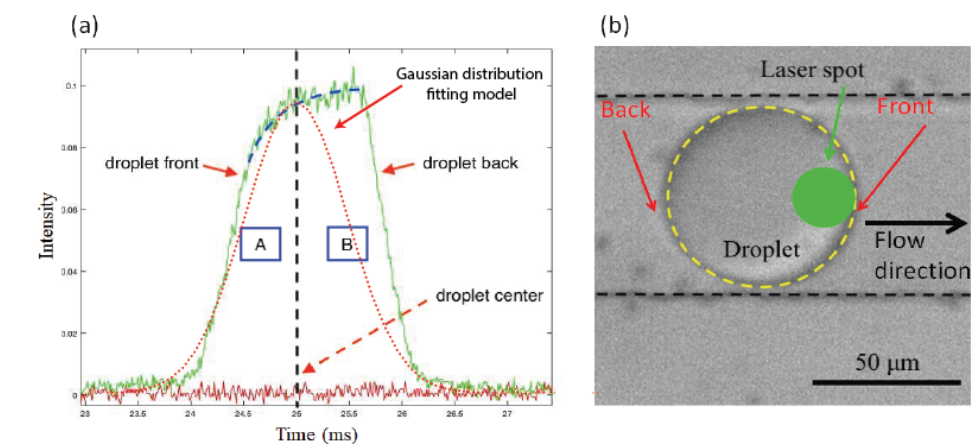
Figure 12. Shape of the fluorescence intensity signal versus time emitted from RhB-doped ZnO microdroplets in the presence of dSURF surfactant ( a ). The corresponding optical microscopic image of the microdroplet flowing inside the microfluidic channel ( b